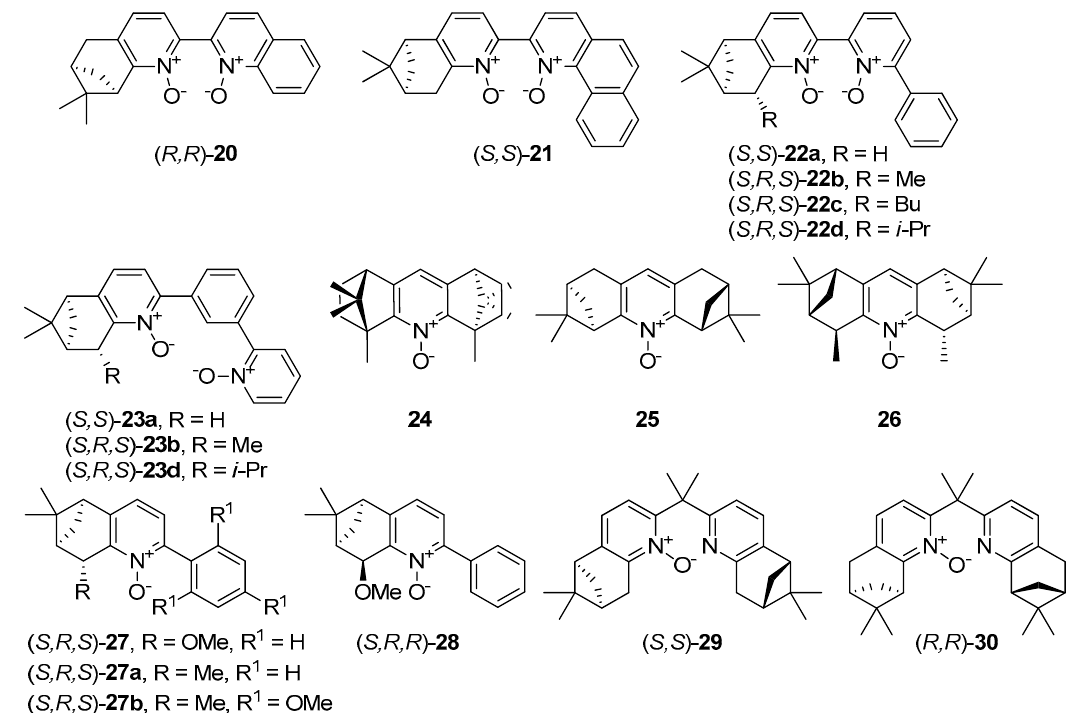
Figure 4. N -oxides possessing fragment from terpenes and alkaloids.